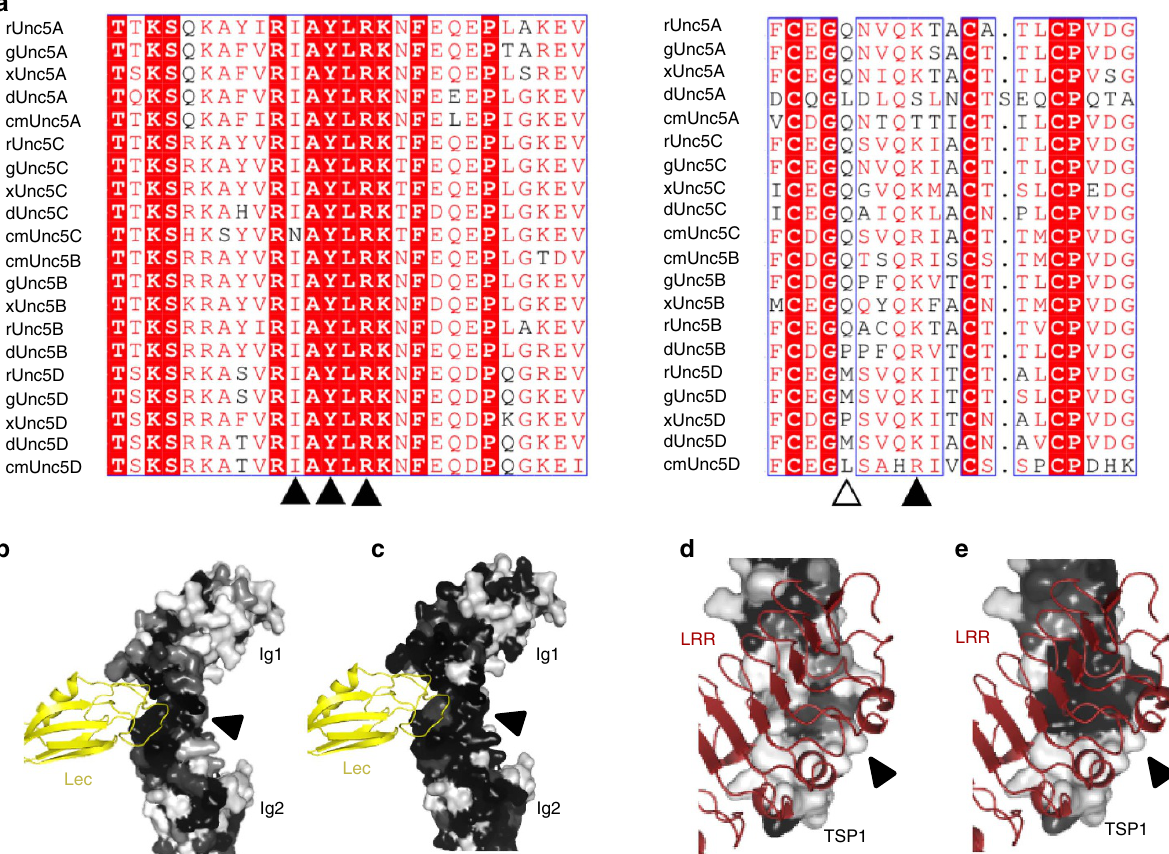
Figure 7 | Sequence conservation across the Unc5 family of proteins. ( a ) Sequence alignments of Unc5A–D from rat (r), chick (g), frog (x), fish (d) and shark (cm) used to calculate conservation scores. Black arrowheads point to mainly conserved residues in interface D (left) and E (right). The empty arrowhead points to a less conserved residue in interface E. ( b – e ) Conservation scores from sequence alignments (human, rat, chick, frog, fish and shark) of all Unc5 homologues ( b , d ) or only Unc5D ( c , e ) were mapped onto the surface of Unc5D. Black: highly conserved; white: not conserved. In our crystal structures, Lphn3 Lec (yellow ribbons) binds Unc5D Ig1 and Ig2 domains (interface D, black arrow head). Interface D residues are conserved across all Unc5 homologues ( b ) and across just Unc5D species ( c ). FLRT2 LRR (dark red ribbons) binds Unc5D TSP1 (interface E, black arrow head). Interface E residues are less conserved across Unc5A–D ( d ) compared with Unc5D species alone ( e ), suggesting that Unc5D is the only Unc5 homologue forming this interface.